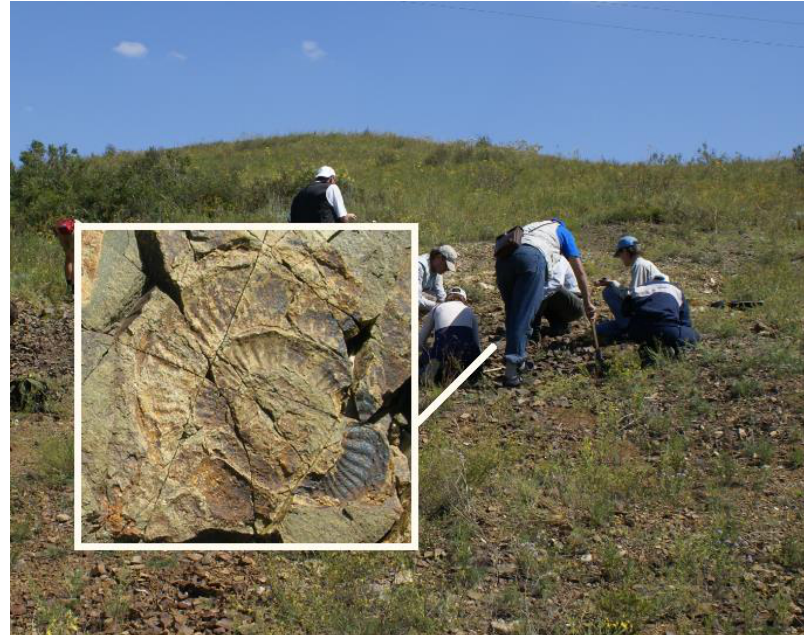
Figure 3. Zavodskie Sopki geosite (ammonoid fossil is shown in insert figure, and geoeducational activity is also